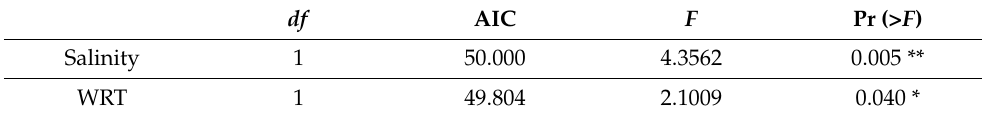
Table 1. Statistically significant explanatory variables for the CPUE (ordistep procedure).